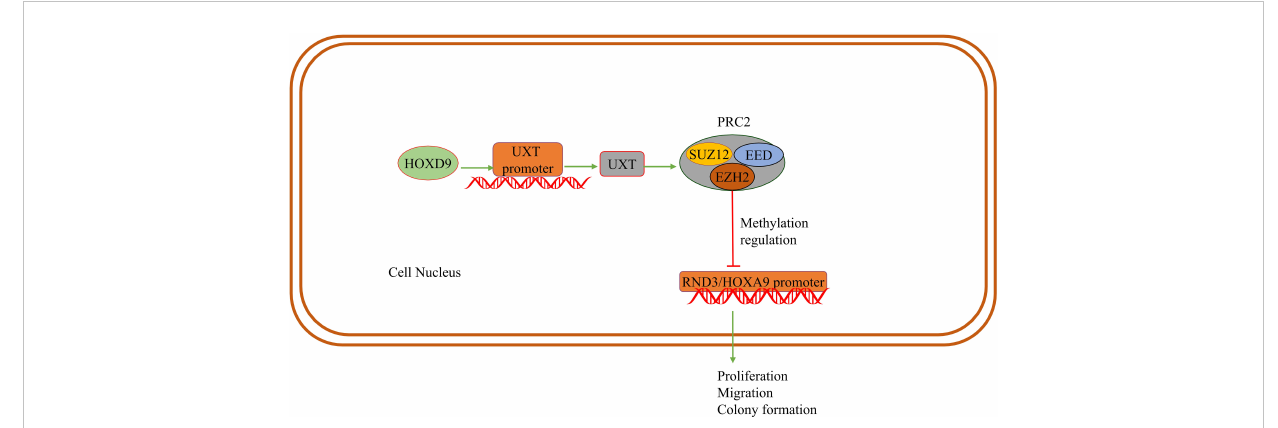
FIGURE 3 UXT and methylation: HOXD9 acts on the UXT promoter to up-regulate UXT expression. UXT promotes methyltransferase activity with EZH2 in PRC2 and methylates the promoter of the tumor suppressor gene RND3/HOXA9 . The expression of RND3/HOXA9 is down-regulated and promotes tumor cell proliferation, migration and colony